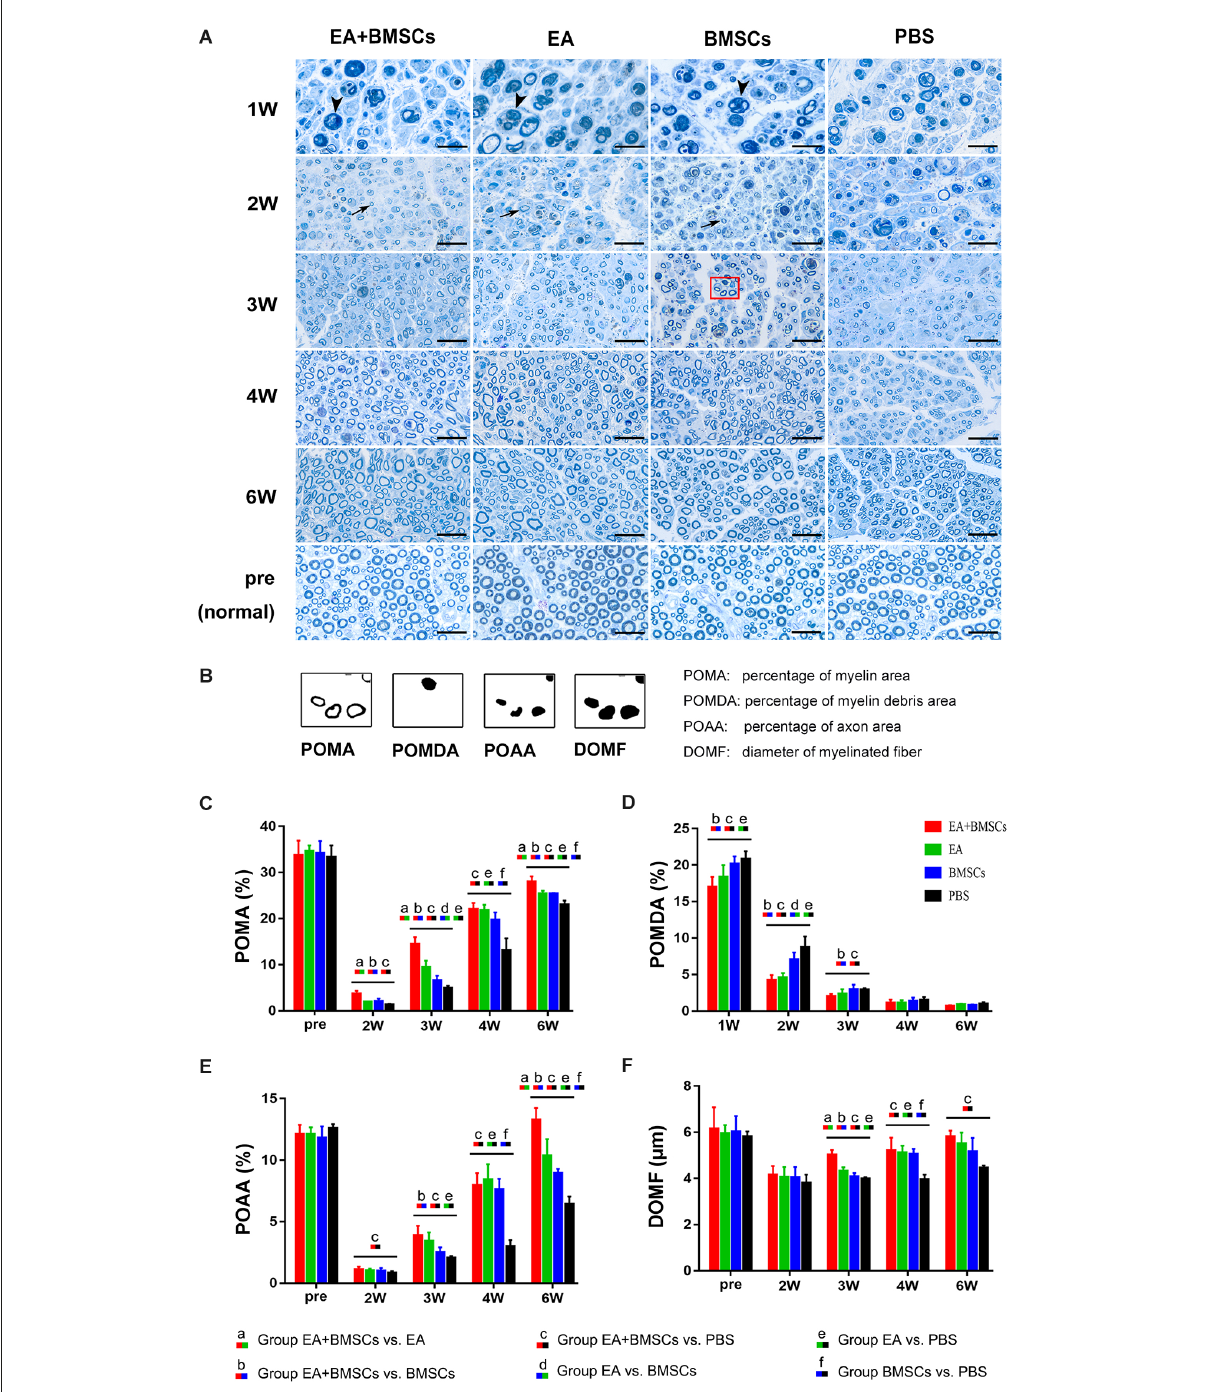
FIGURE4 Toluidine blue staining of the distal stumps of injured and uninjured contralateral nerves. (A) Representative cross-sectional micrographs exhibiting axonal degeneration and myelin disintegration at 1 and 2 weeks post-surgery. The arrowheads denote the myelin debris, which was removed with nerve repaired. By the second week, new myelin sheaths begin to appear, which were thin and small (arrows). Pronounced axonal regeneration and remyelination were observed at 6 weeks post-operation. W: week. Scale bars = 20 µ m. (B) Semi-quantitative analysis of the four pathological indicators. (C–F) Percentage of myelin area (POMA), percentage of myelin debris area (POMDA), percentage of axon area (POAA), and diameter of myelinated nerve fibers (DOMF) in the distal stumps of the injured nerves of all groups compared to their contralateral uninjured nerves (control group) at about 2–6 weeks post-surgery. The POMA, POMDA, POAA, and DOMF values of acquisition points within groups were compared by using one-way ANOVA with Bonferroni post-hoc testing, and statistically significant differences are listed in Table 3